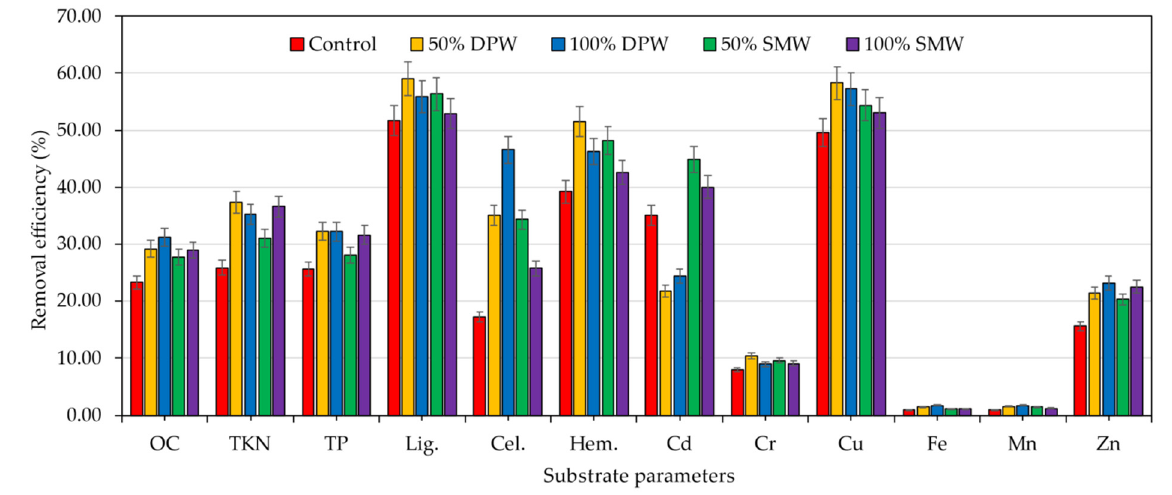
Figure 2. Removal efficiency of the tested chemical components in the mushroom substrate after Shiitake cultivation.